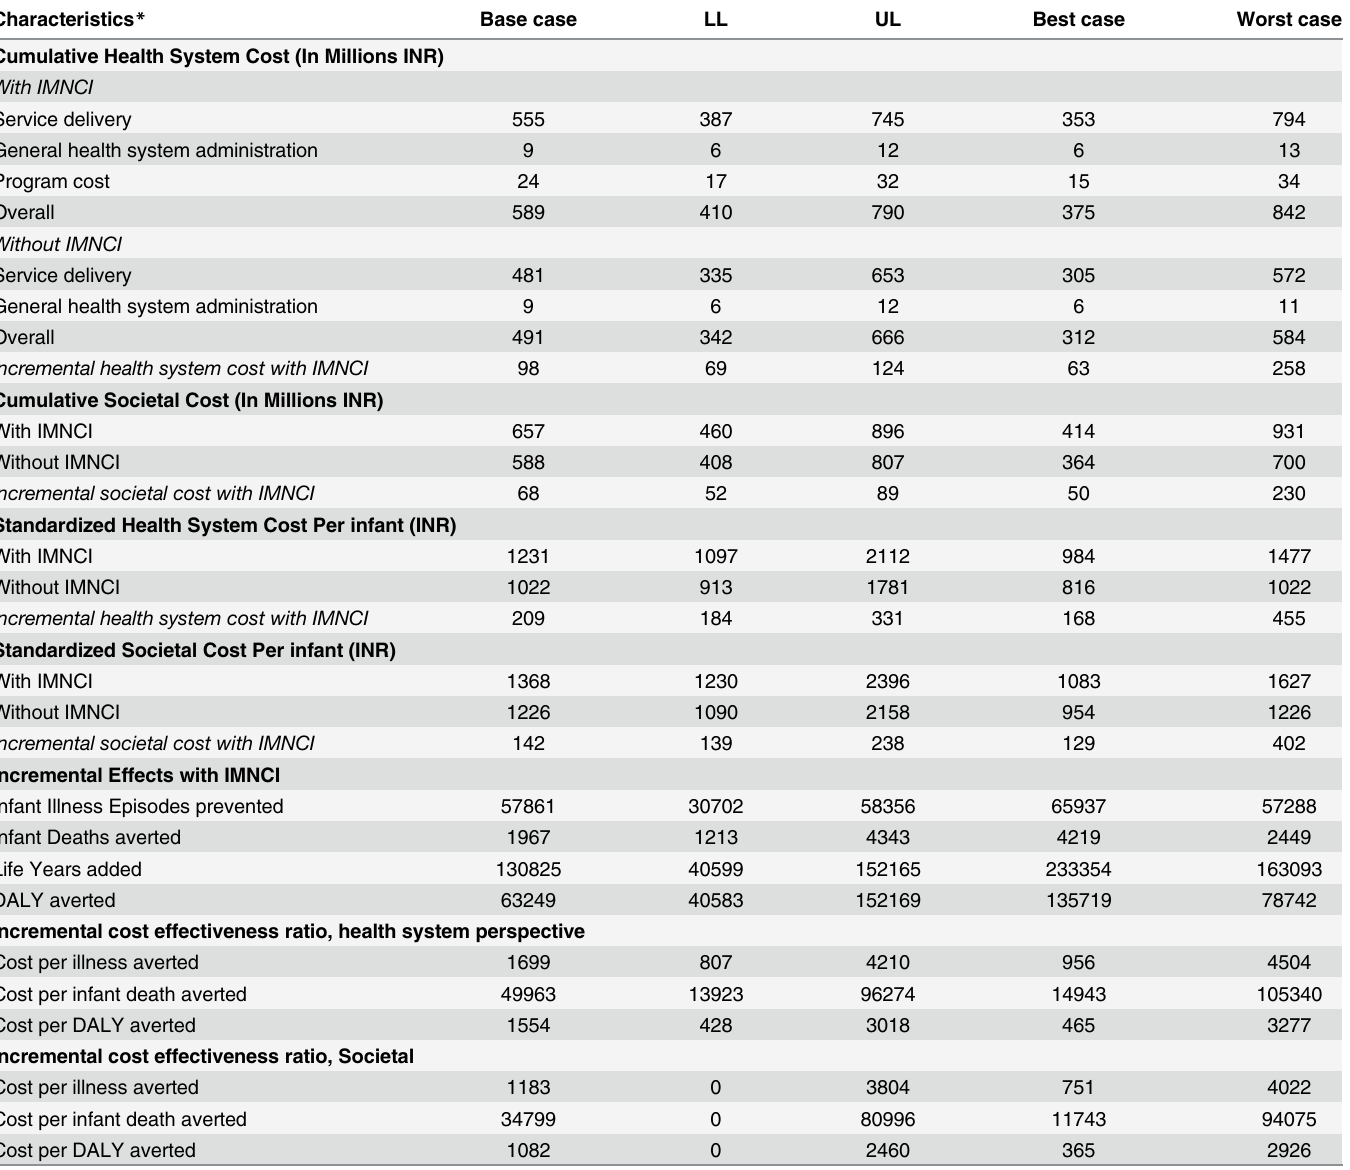
Table 4. Cost, Effects and Cost-Ef fectiveness of IMNCI Program in India. Characteristics